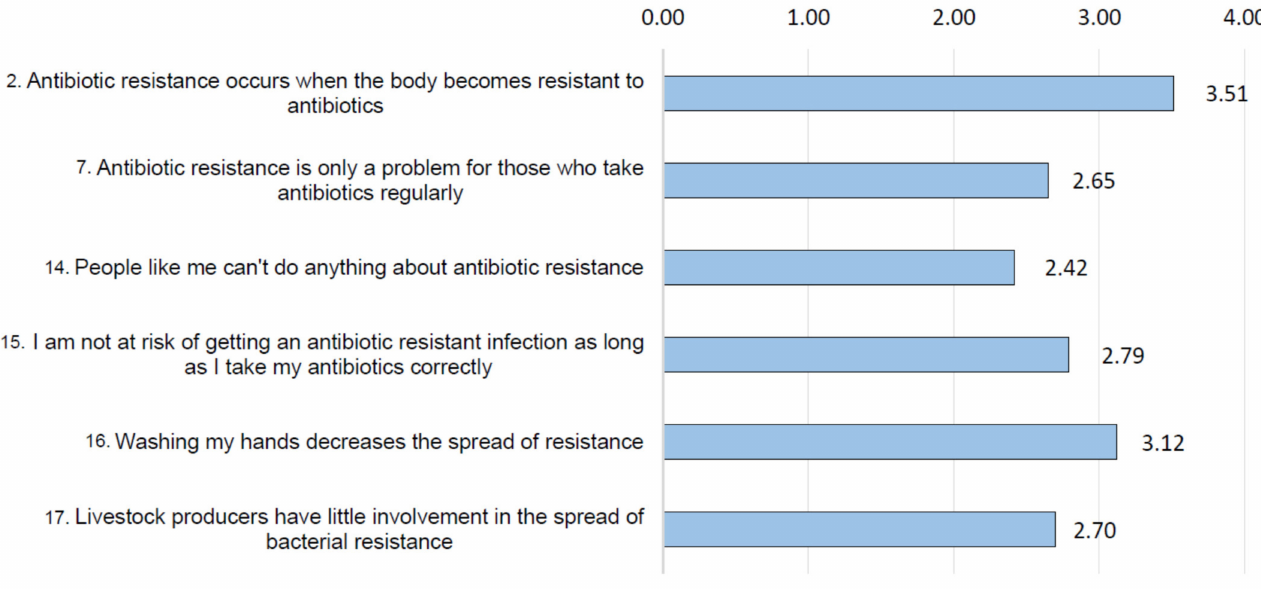
Figure 4. Mean score obtained by respondents about ABR knowledge and its transmission (question #8, items 2, 7, 14, 15, 16, 17; score from 1 to